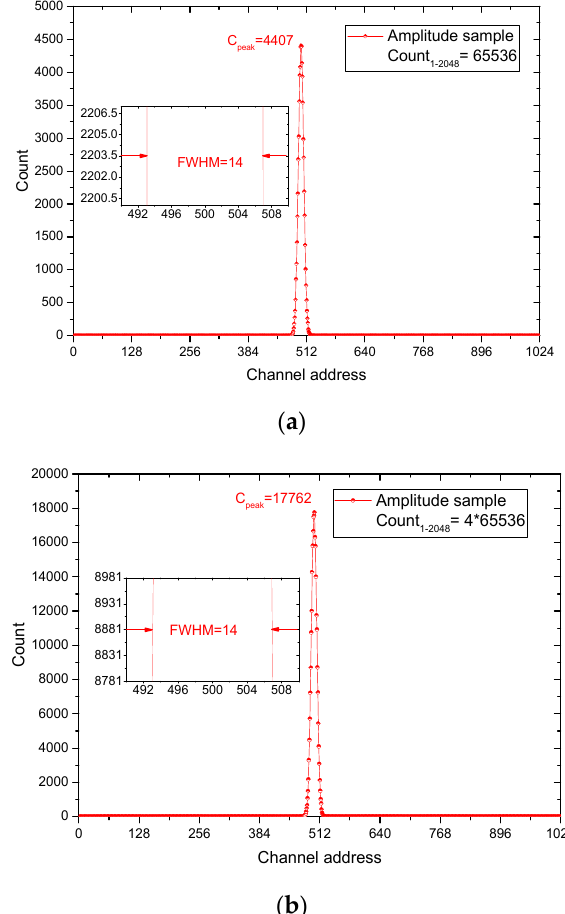
Figure 5. Spectral contrast maps obtained before and after multiplication. ( a ) Original spectrum; ( b ) multiplication spectrum.